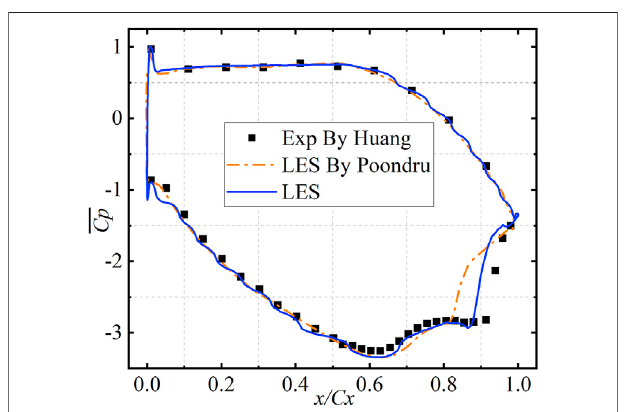
FIGURE 4 | Time-averaged and spanwise-averaged wall-pressure coef fi cient distribution compared with experimental data by Huang and LES data by Poondru.